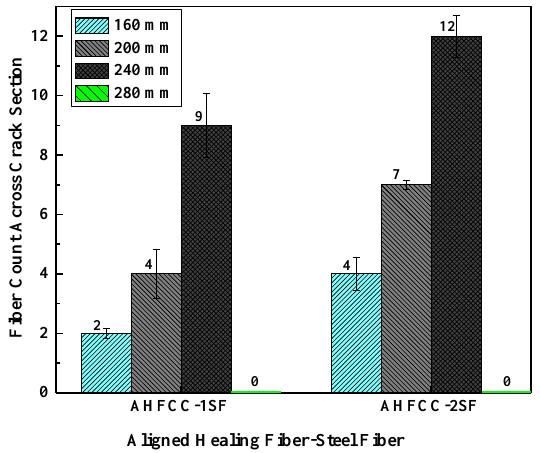
Figure 4. Optimal requirements analysis for the automatic alignment process.